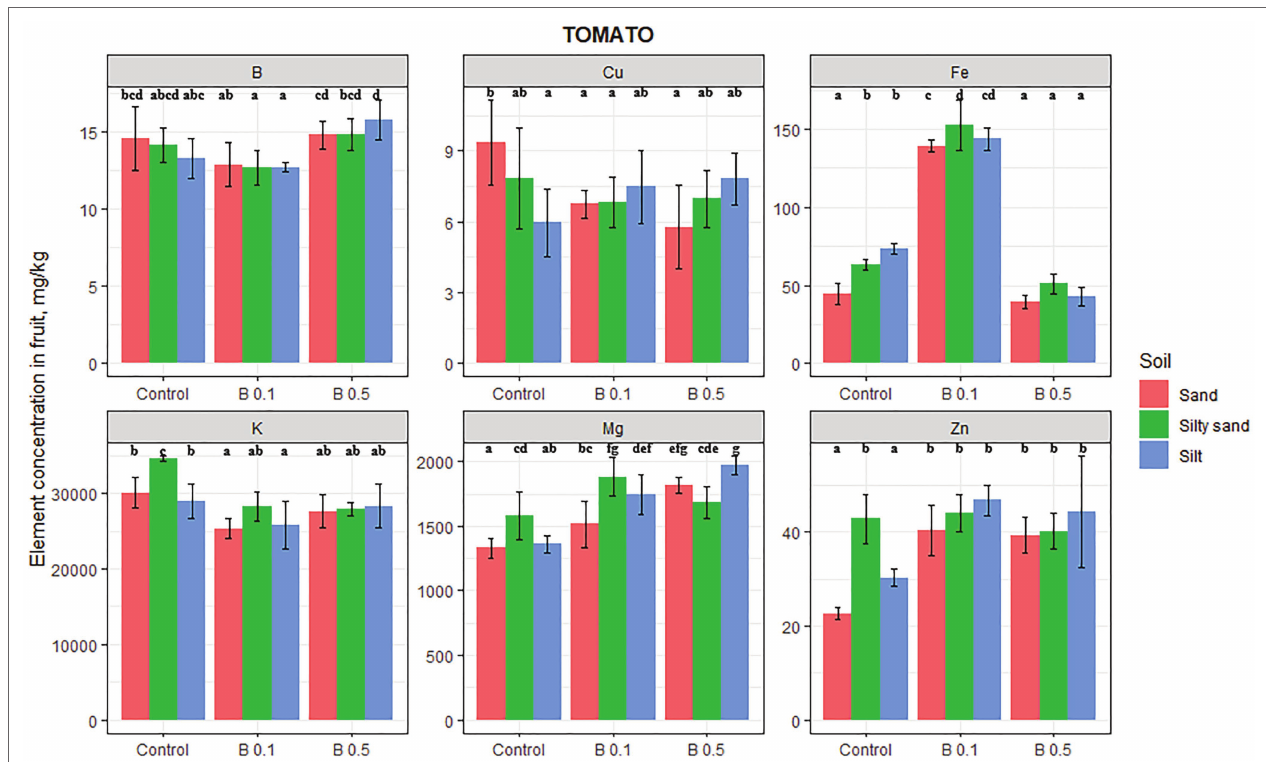
FIGURE 1 | Element contents in tomato fruit in different irrigation water treatments on sand, silty sand, and silty soil (mg/kg DW). The data are means of the replicates. Different letters (a–g) indicate significant differences between treatments ( p <